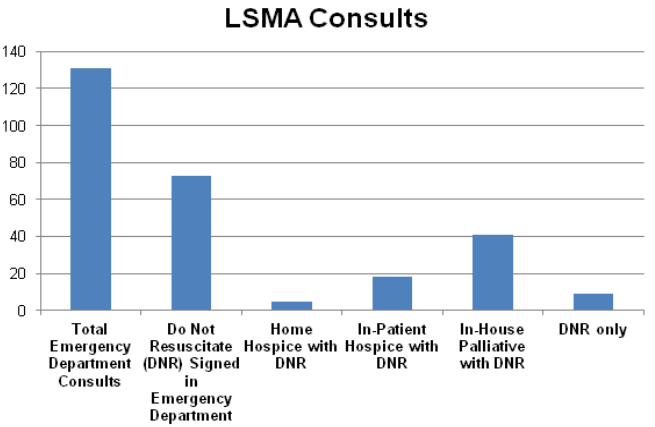
Figure 2. Emergency department palliative care consults March 2010 to July 2011 (n =